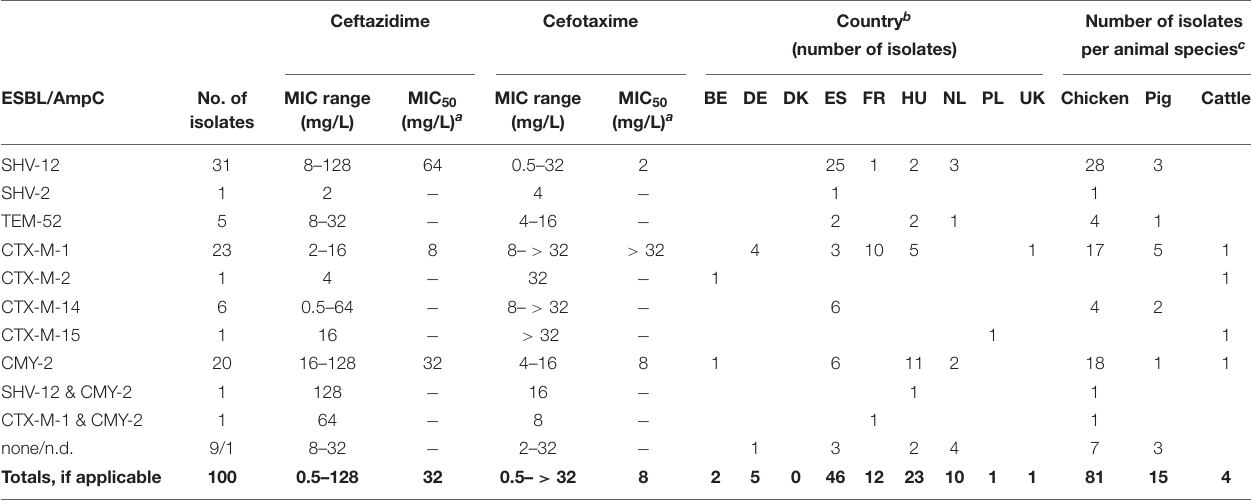
TABLE 1 | ESBL/pAmpC types in ESC-R E. coli ( n = 99) and E. fergusonii ( n = 1) from the EASSA collection